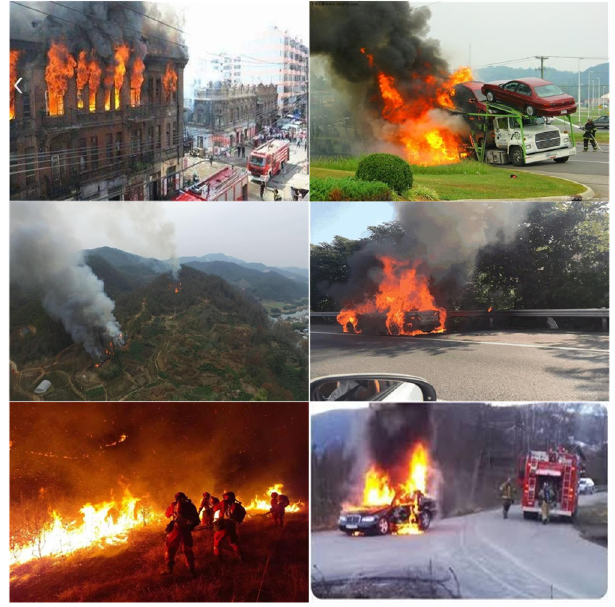
Figure 6. Example images of the dataset.